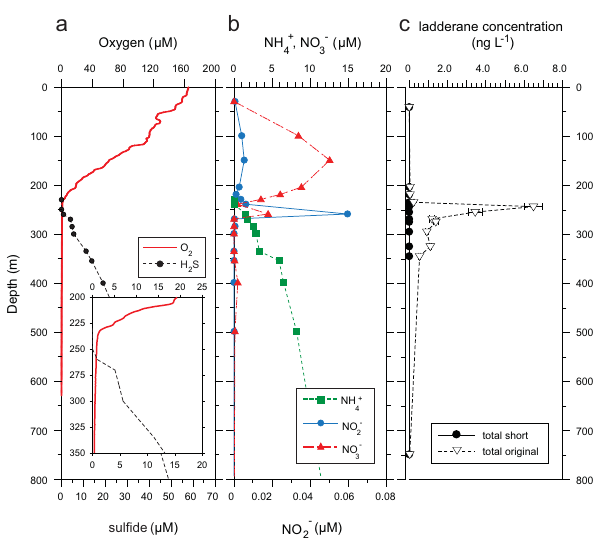
Fig. 3. (a) Oxygen (red line), H 2 S (black circles), (b) NH + (green 4 squares), NO − (blue circles), and NO − (red triangles) concentra- 2 3 tions obtained during CTD pumping casts at the Cariaco Basin time series site during cruise 139 (CAR139). (c) Concentrations of orig- inal (open triangles) and short chain (filled circles) ladderane fatty acids were obtained from in situ pump filters. Data, except those of short chain ladderane fatty acids, from Wakeham et al.